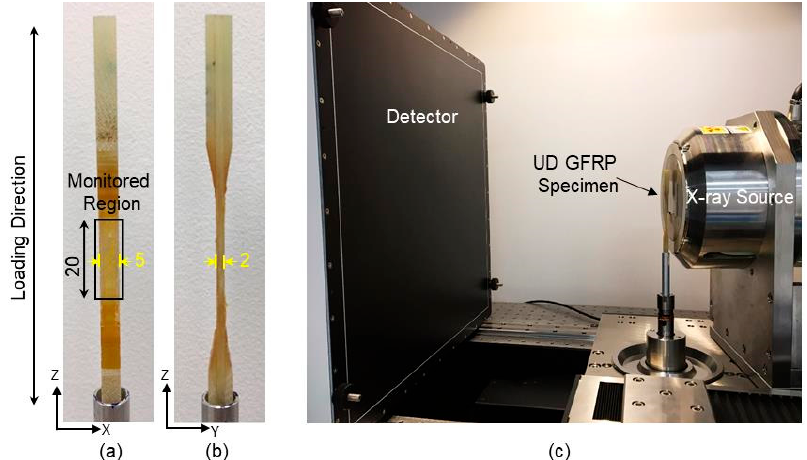
Figure 2. ( a , b ) Photographs illustrating the GFRP specimen geometry and the X-ray CT monitored region through interrupted fatigue test (dimensions in mm). ( c ) Photograph showing the helical X-ray CT imaging set-up in the ThermoFisher HeliScan Micro-CT scanner.